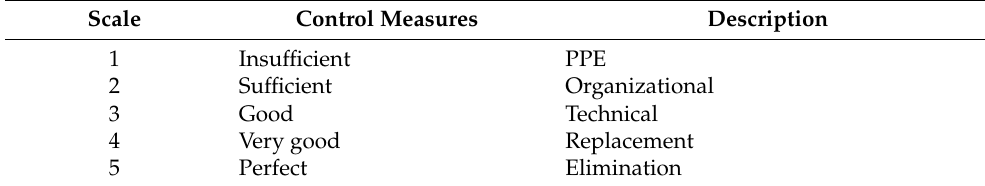
Table 3. Scale of the hierarchy of risk control measures.